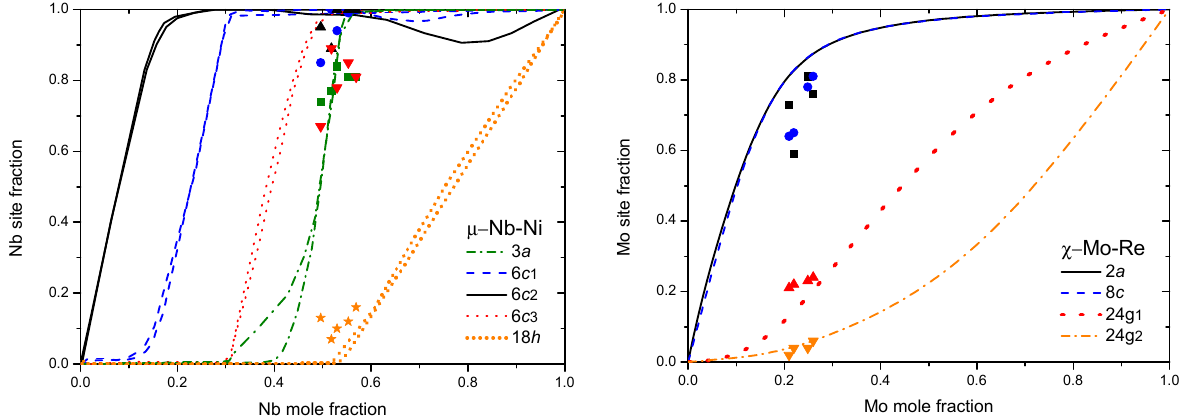
Figure 5. ( left ) Nb site fraction in µ Nb-Ni obtained by both CWM-CVM and DFT-BWA at 1,273 K [35], experimental data from [17]. ( right ) Mo site fraction in χ Mo-Re obtained by DFT-BWA at 1,873 K [36], experimental points from